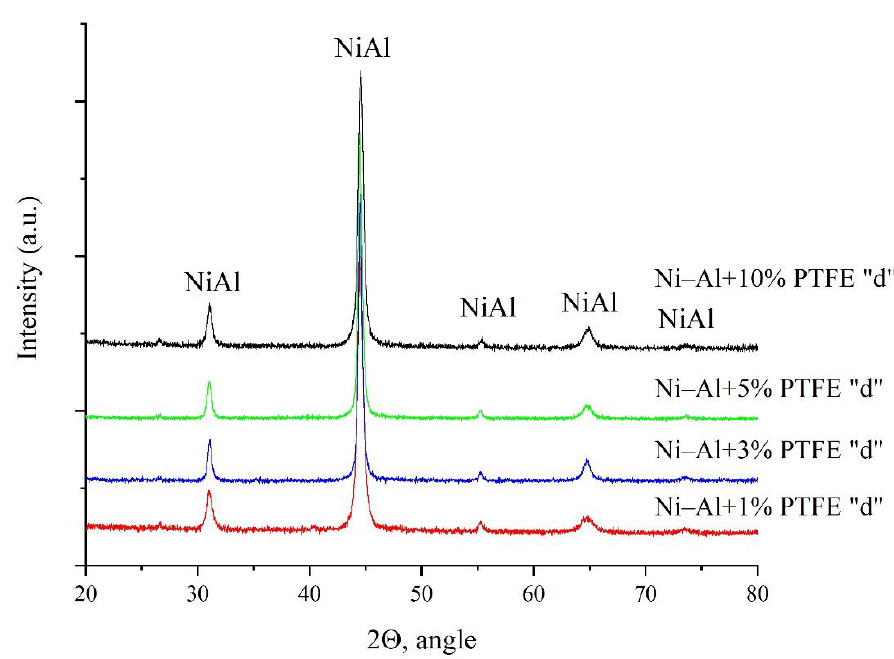
Figure 14. XRD of burned Ni – Al – PTFE specimens.